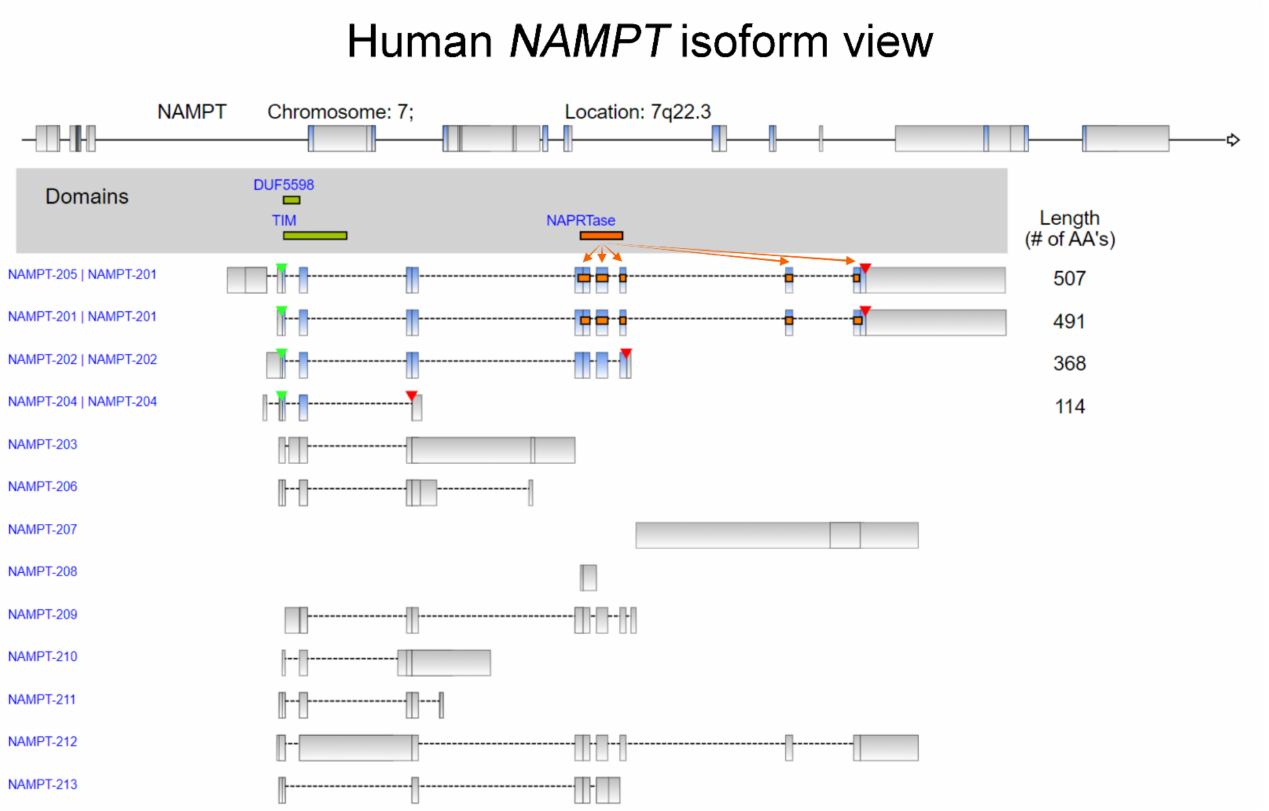
Figure 1. Isoform view of human NAMPT . The position of the stop codon and start site of transcription are indicated by red and green arrowheads, respectively. The matched NAPRTase protein domain in each isoform is marked in orange. The data were retrieved from Ensembl and